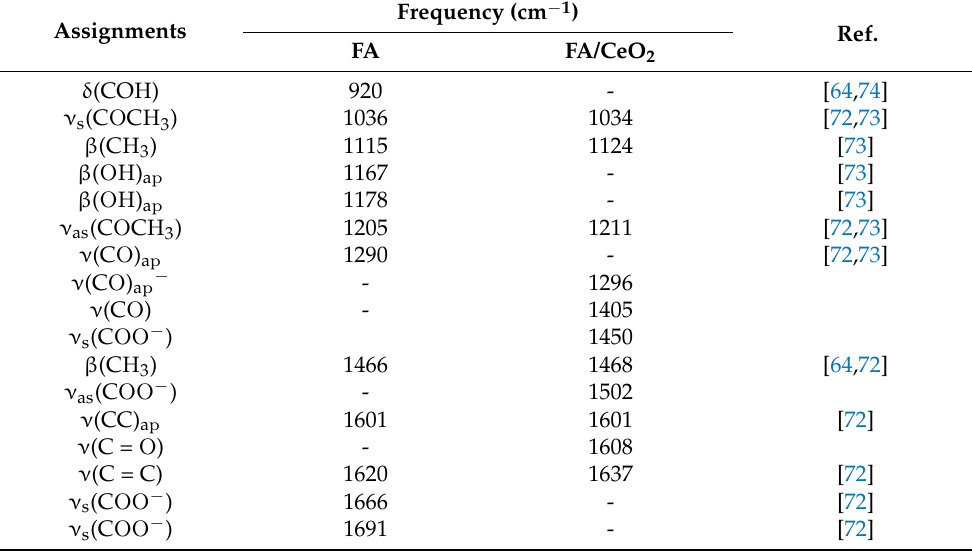
Figure 4. Fourier transform-infrared spectra of pure CeO 2 (a), samples of FA/CeO 2 with different contents of FA (0.1: b; 0.3: c; 0.6: d; 0.9: e; 1.2 mmol/g: f) and pure FA (g). Table 4. Assignments of characteristic infrared bands of pure FA and of FA/CeO 2 (0.6